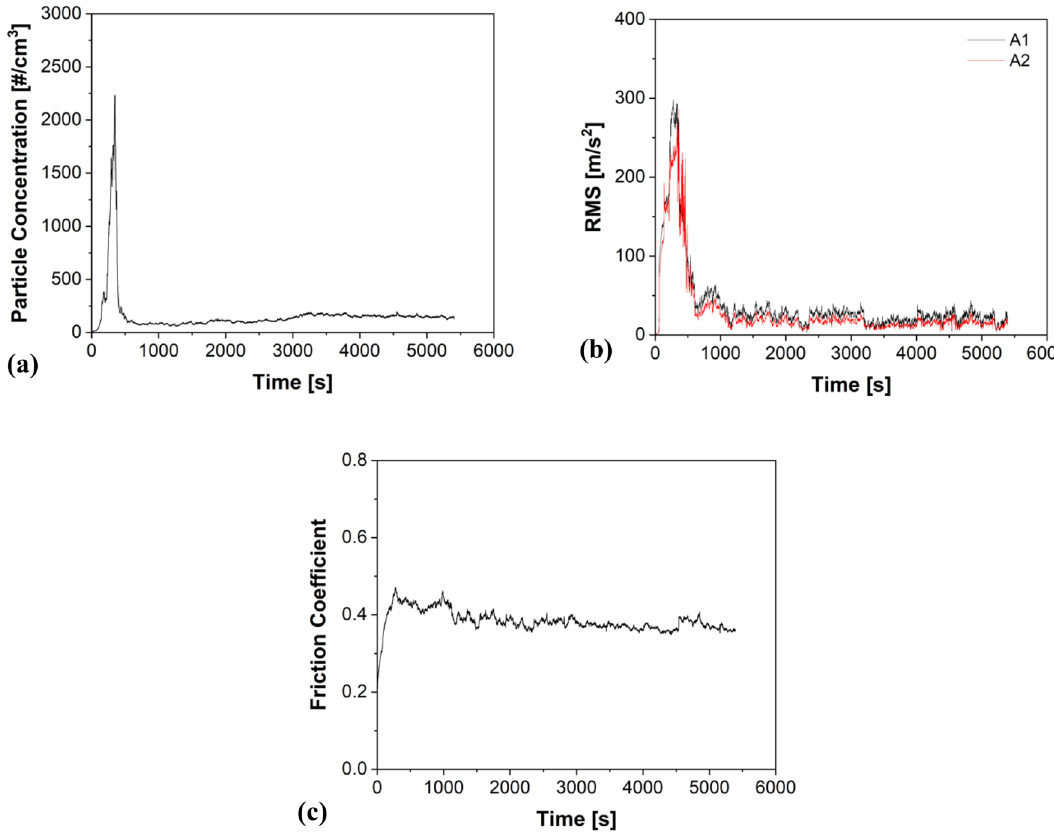
Figure 2. A typical example of ( a ) Emissions; ( b ) Vibrations; and ( c ) CoF trends demonstrated by MC specimens with the damping